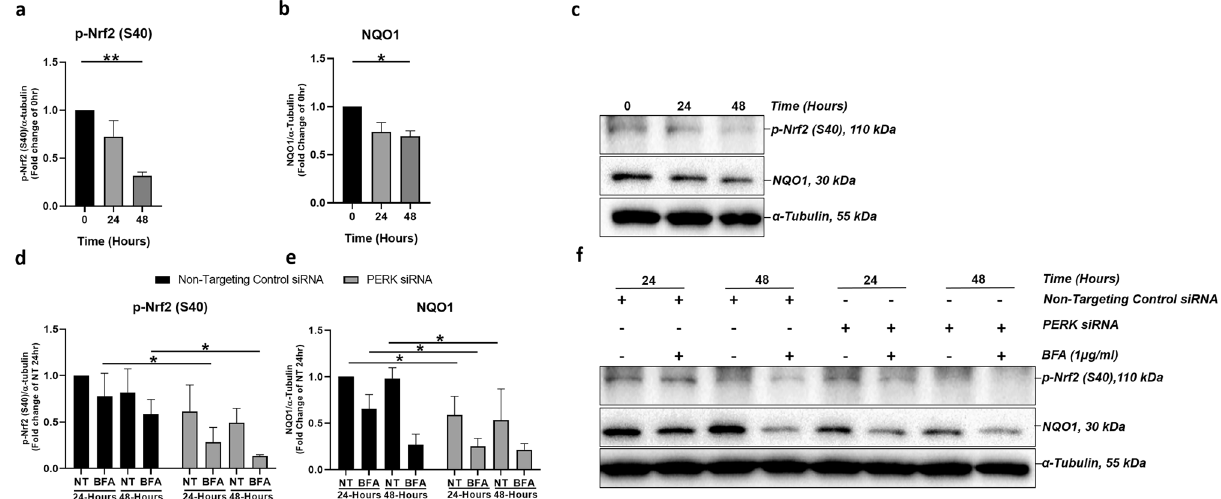
Figure 3. PERK downregulation impairs Nrf2 signalling and the response to BFA-induced ER-stress in ARPE-19 cells. ARPE-19 cells treated with 1 μg/ml BFA for 0–48 h resulted in a significant downregulation of ( a ) p-Nrf2 (S40) at 48 h and ( b ) NQO1 protein expression at 24 and 48-h time-points; ( c ) representative immunoblots shown. When ER stress was induced in APRE-19 cells in the presence of PERK siRNA there was a significant downregulation in ( d ) p-NRF2 (S40) at 24-h and 48-h in addition to ( e ) NQO1 at a 24-h time point compared to non-transfected control siRNA groups. When transfected with PERK siRNA, there was also a reduction in NQO1 protein expression in NT groups at 24 h and 48-h time points when compared to NT groups transfected with non-targeting control siRNA. ( f ) Representative immunoblots shown. Results are presented as fold-changes from 0-h time point ( a – c ) or the NT Non-Targeting Control siRNA group at a 24 h time point ( d – f ). Protein levels were normalised to α-tubulin. Means ± standard deviation shown (n = 3). Statistical analysis was performed using either the one-way ANOVA with Dunnet’s multiple-comparison test ( a , b ) or two-way ANOVA with Sidak’s multiple-comparison test ( d – e ) (* p ≤ 0.05, ** p ≤ 0.01, *** p ≤ 0.001, **** p ≤ 0.0001). p-Nrf2 (S40) = Nrf2 phosphorylated at serine 40. NT non-treated, BFA Brefeldin